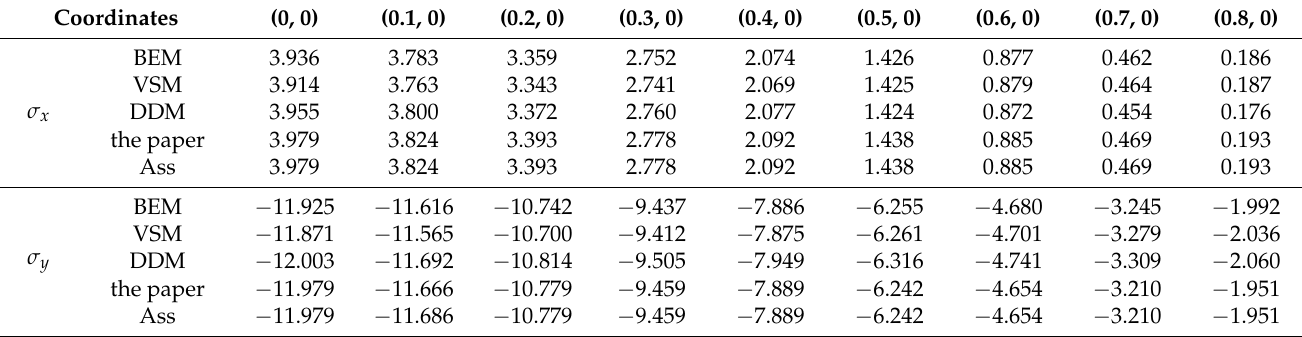
Table 2. The stresses σ x (MPa) and σ y (MPa) at points ( x dm and y = 0) of the axial compression on the part boundary of the circular